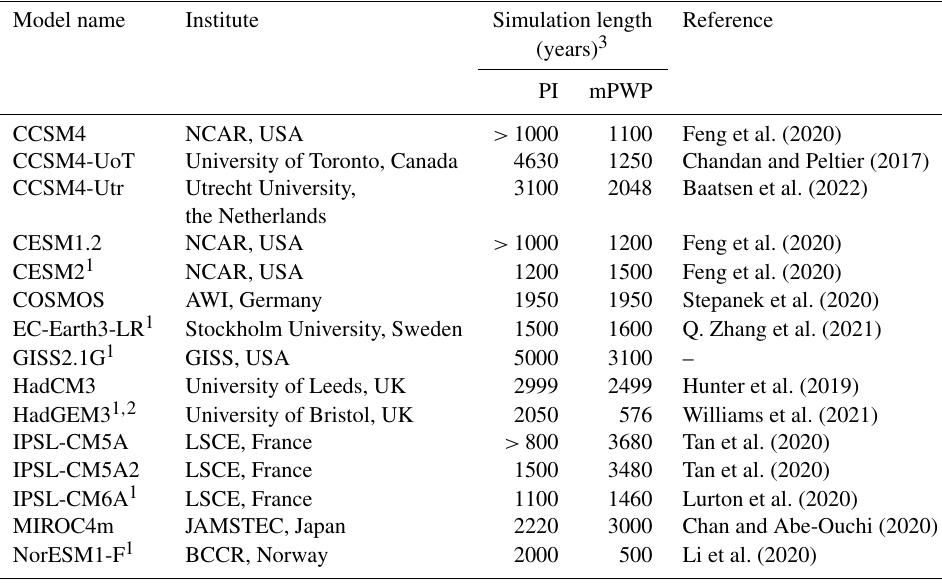
Table 1. Overview of PlioMIP2 models used in this